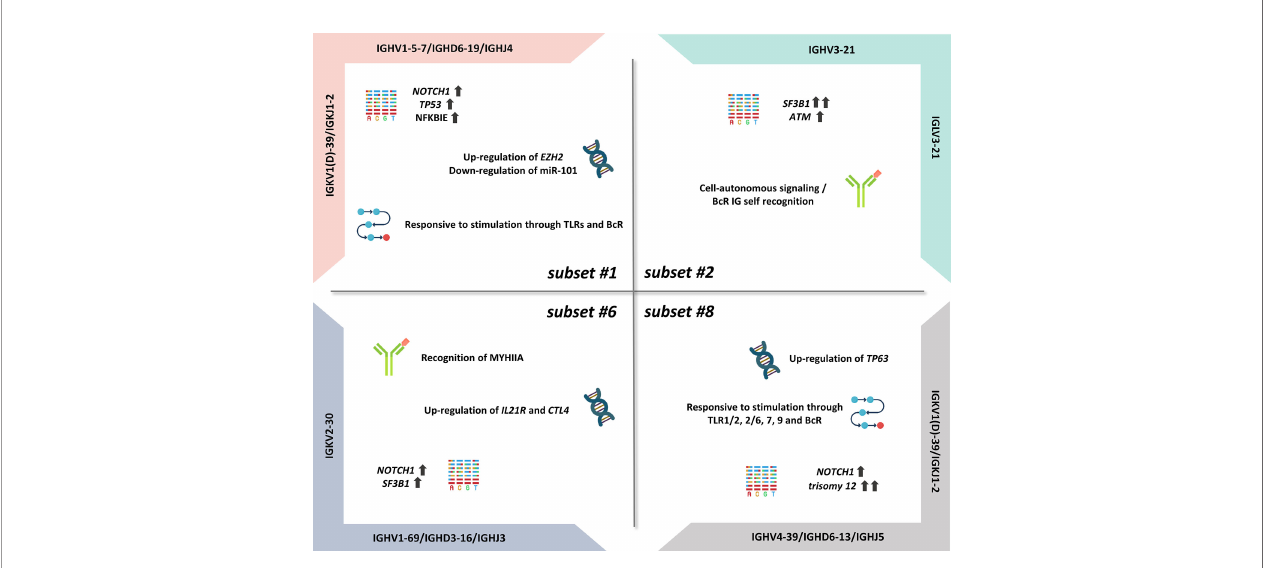
FIGURE 1 | Summary of the biological features of aggressive CLL